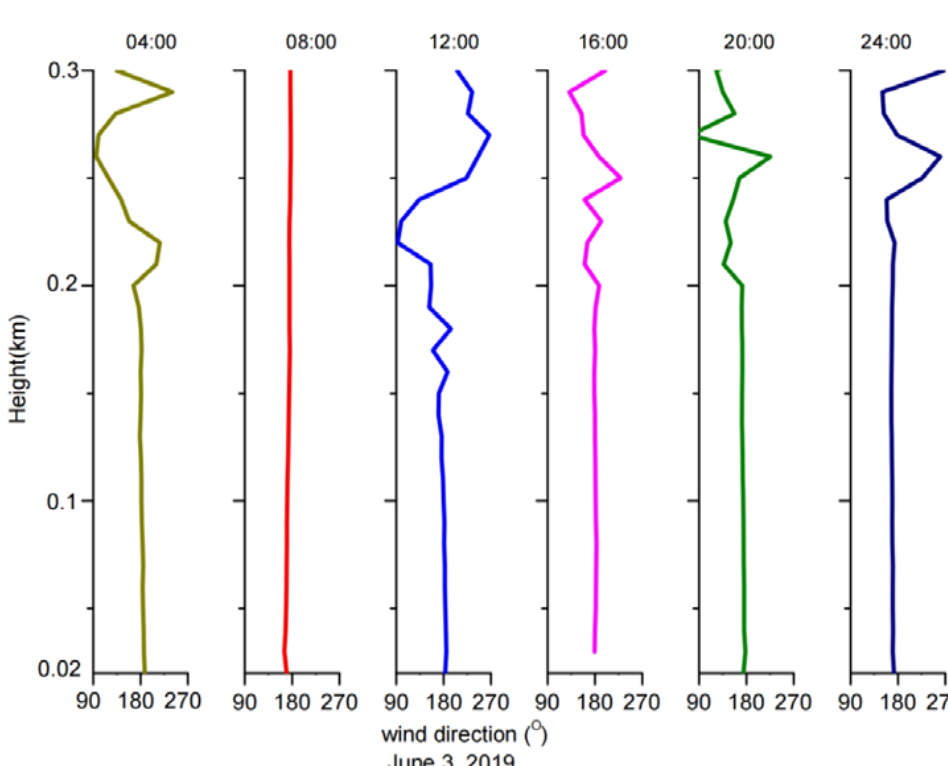
Figure 6. Wind direction profiles measured from sodar on 3 June 2019.